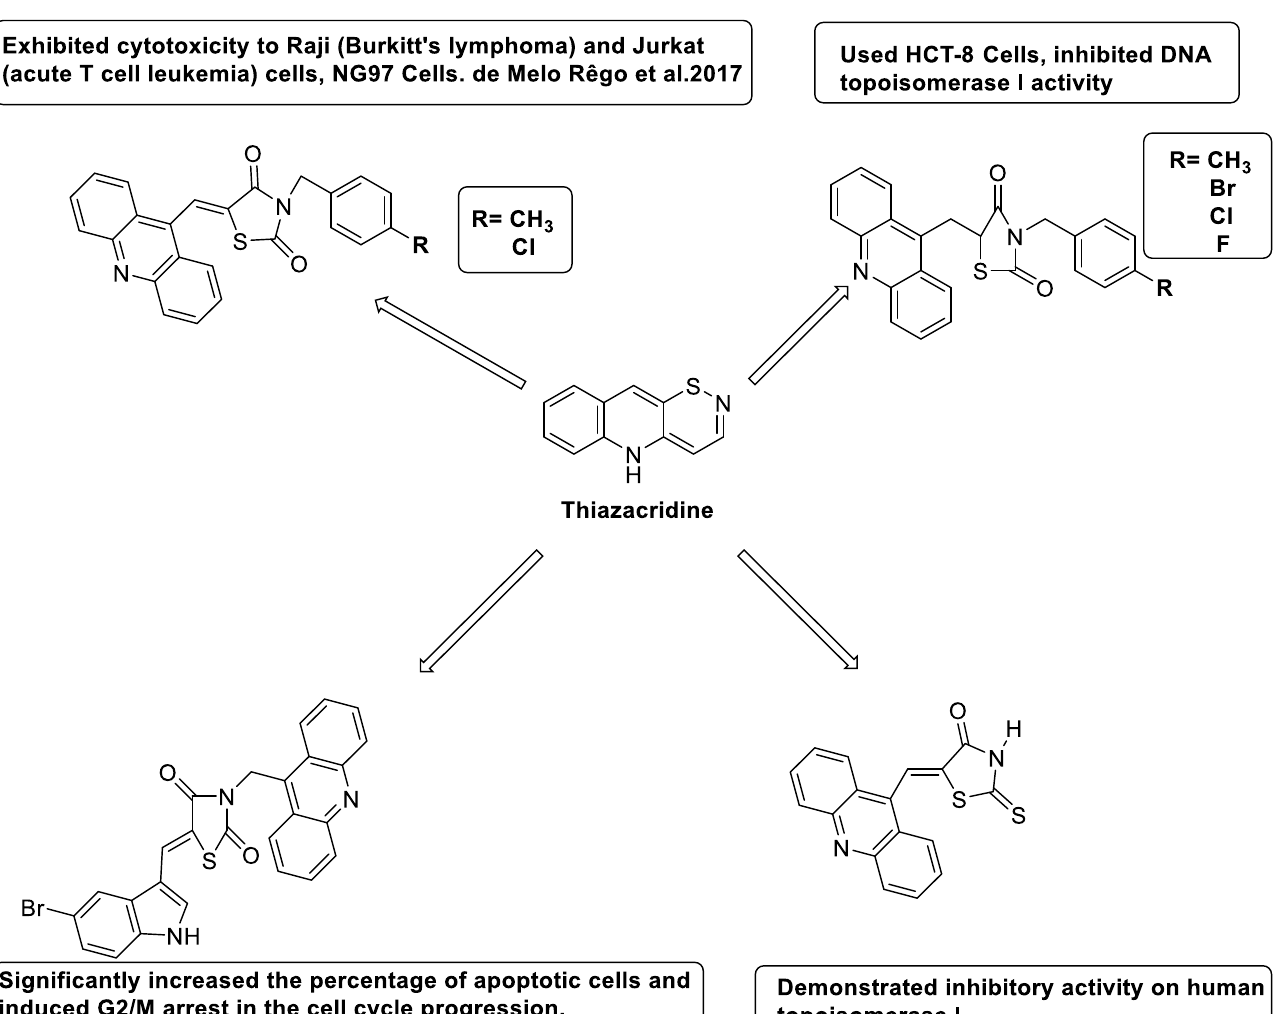
Figure 12. SAR of thiazacridine derivatives. Table 14. Thiazacridine as an anti-tumour agent.